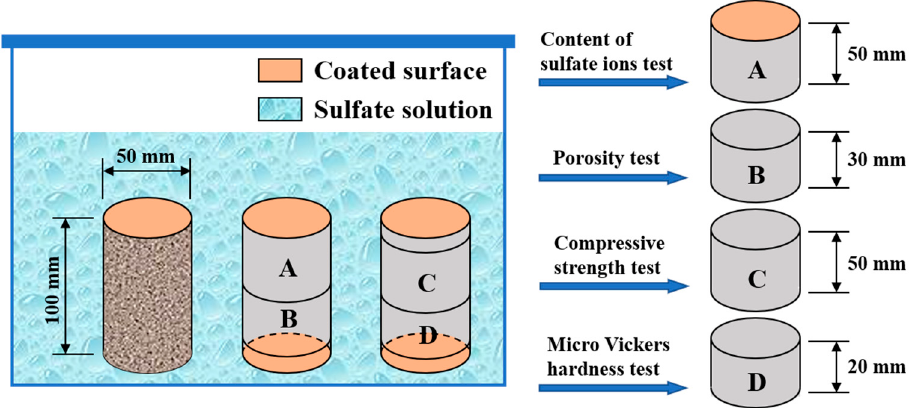
Figure 3. Schematic diagram of the experimental scheme.